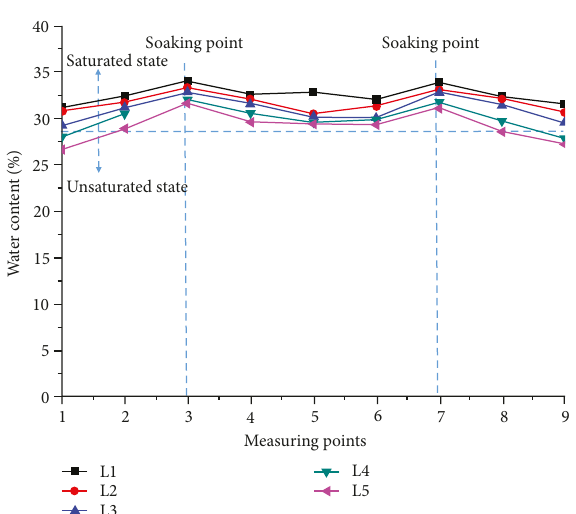
Figure 5: Experimental process